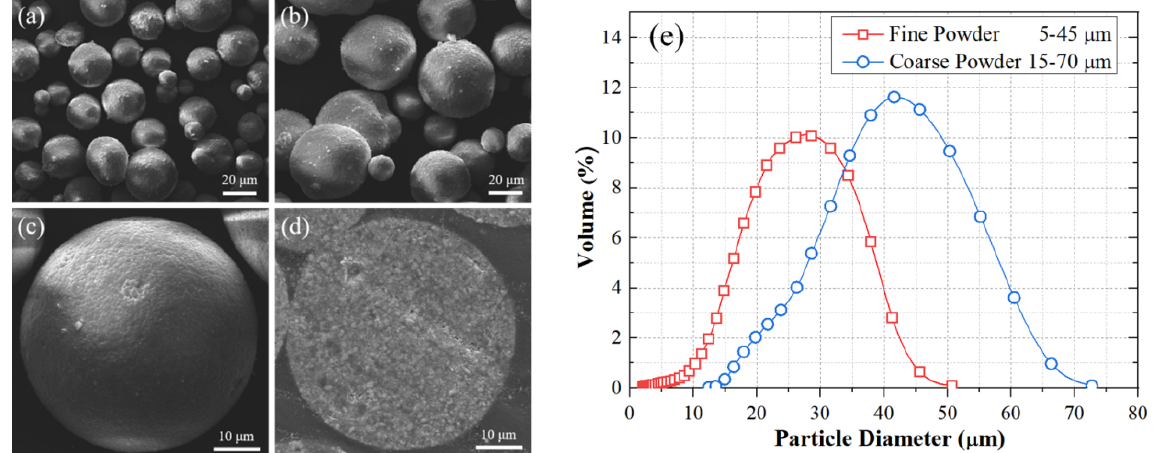
Figure 1. Morphology and particle size distribution of the two kinds of YSZ powders: ( a ) fine powder; ( b ) coarse powder; ( c ) magnification of powder surface morphology; ( d ) magnification of powder cross-section morphology and ( e ) particle size distribution.